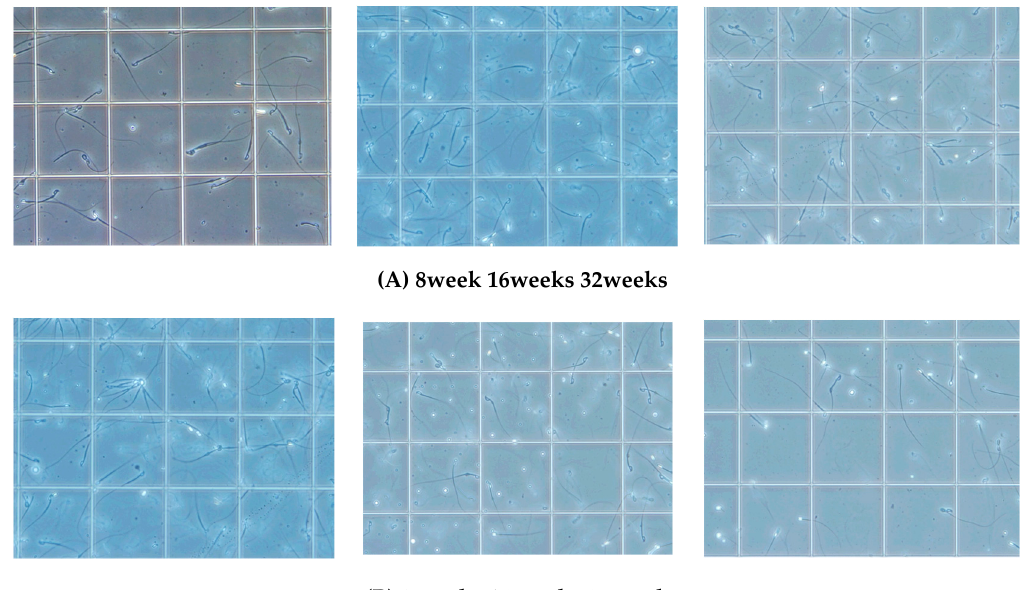
Figure 3. Video of sperm movement ( × 200). Video records of sperm movement at 8, 16, and 32 weeks of age of wild-type mouse ( A , upper movie, double click to start) and KCASP1Tg mouse ( B , lower movie) were shown. The number of sperm was low, and movement was slow in KCASP1Tg mouse.